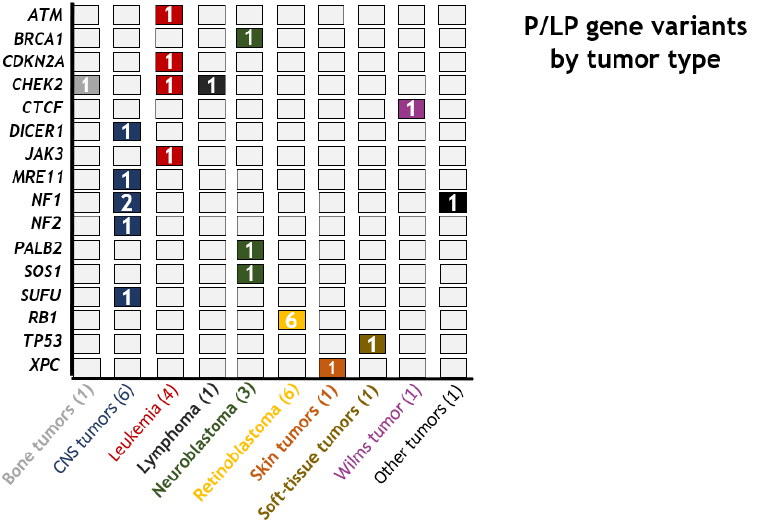
Figure 3. Genes and tumor types whereby pathogenic or likely pathogenic variants were